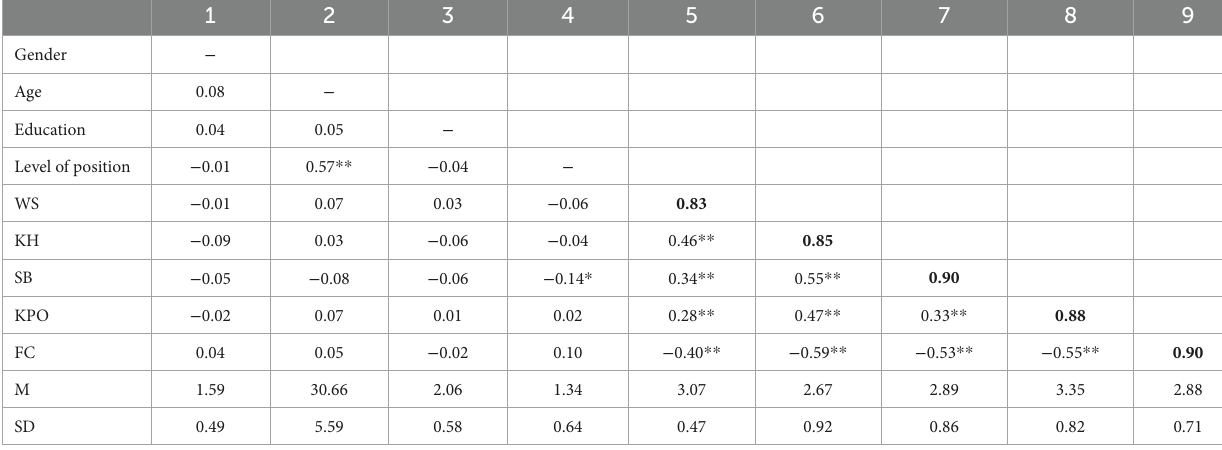
TABLE 2 Descriptive statistical results and correlation coefficients